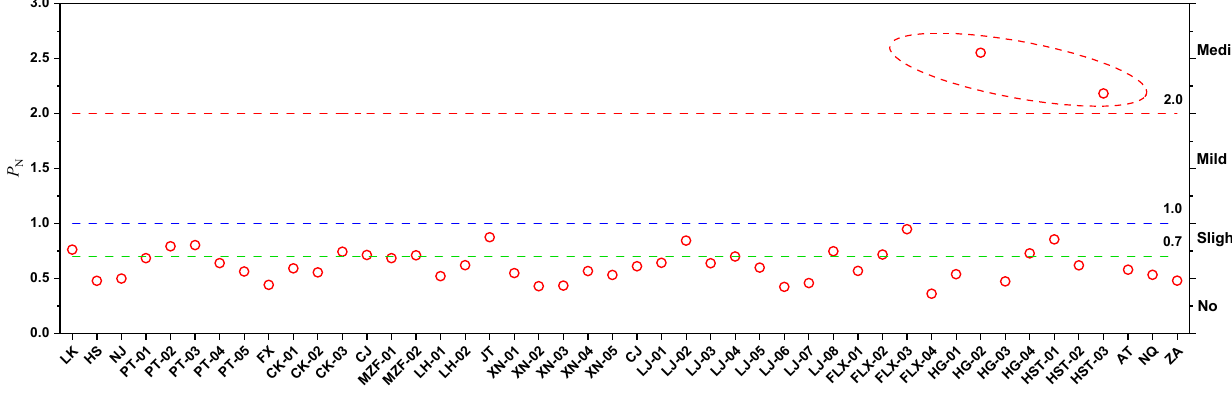
Figure 4. The Nemerow comprehensive pollution index ( P N ) of five heavy metals in the subsurface soil of the study area.